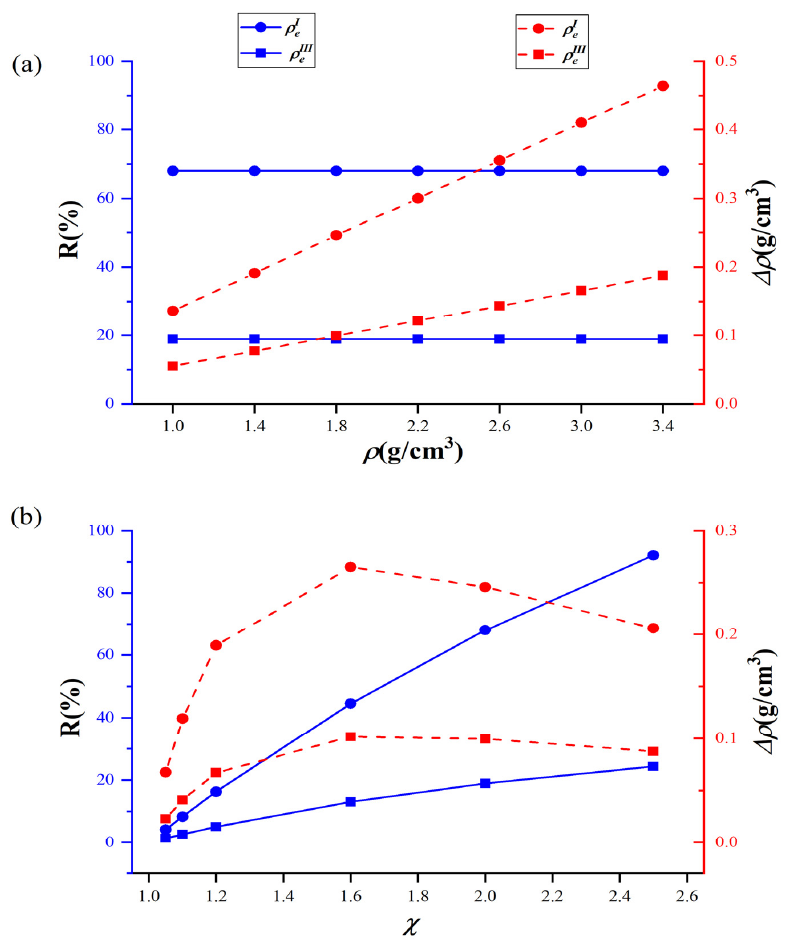
Figure 2. ( a ) Δ ρ (= ρ e ,40nm − ρ e ,550nm ) and R (= Δ ρ / ρ e ,550nm ) of ρ e I and ρ e III for the Y particles with different ρ ; ( b ) Δρ (= ρ e ,40nm − ρ e ,550nm ) and R (= Δ ρ / ρ e ,550nm ) of ρ e I and ρ e III for the Z particles with different χ . Red and blue lines represent Δ ρ and R, respectively.